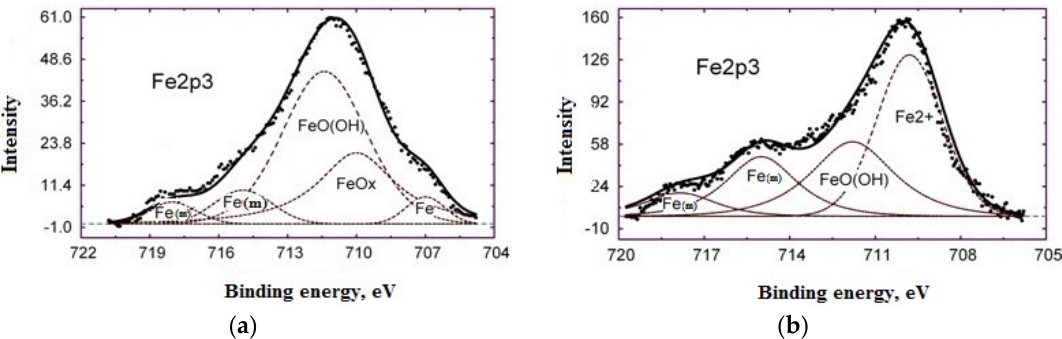
Figure 4. ( a ) XPS spectrum of Fe 2p 3/2 electrons of steel surface: an after exposure of steel samples in the background electrolyte (10 min); ( b ) after exposure of steel samples in the background electrolyte with the addition of 5mM benzotriazole (BTA) (duration 10 min). The chemical species are given in the spectra. Fe (m) – metallic iron.